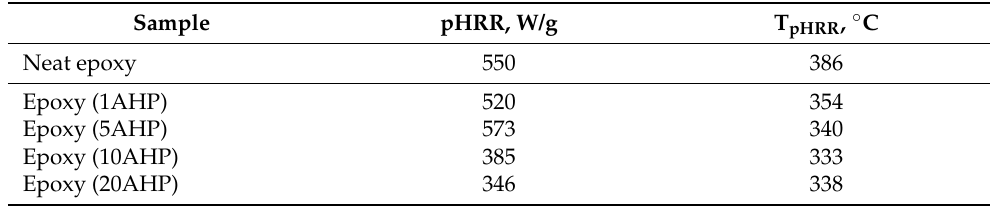
Figure 5. Heat release rate (HRR) curves vs. the temperature of neat epoxy and epoxy/AHP nanocomposites obtained by PCFC analysis. Table 3. The values of peak of heat release rate (pHRR) and temperature at the peak of the heat release rate (T pHRR ) obtained by PCFC analysis.